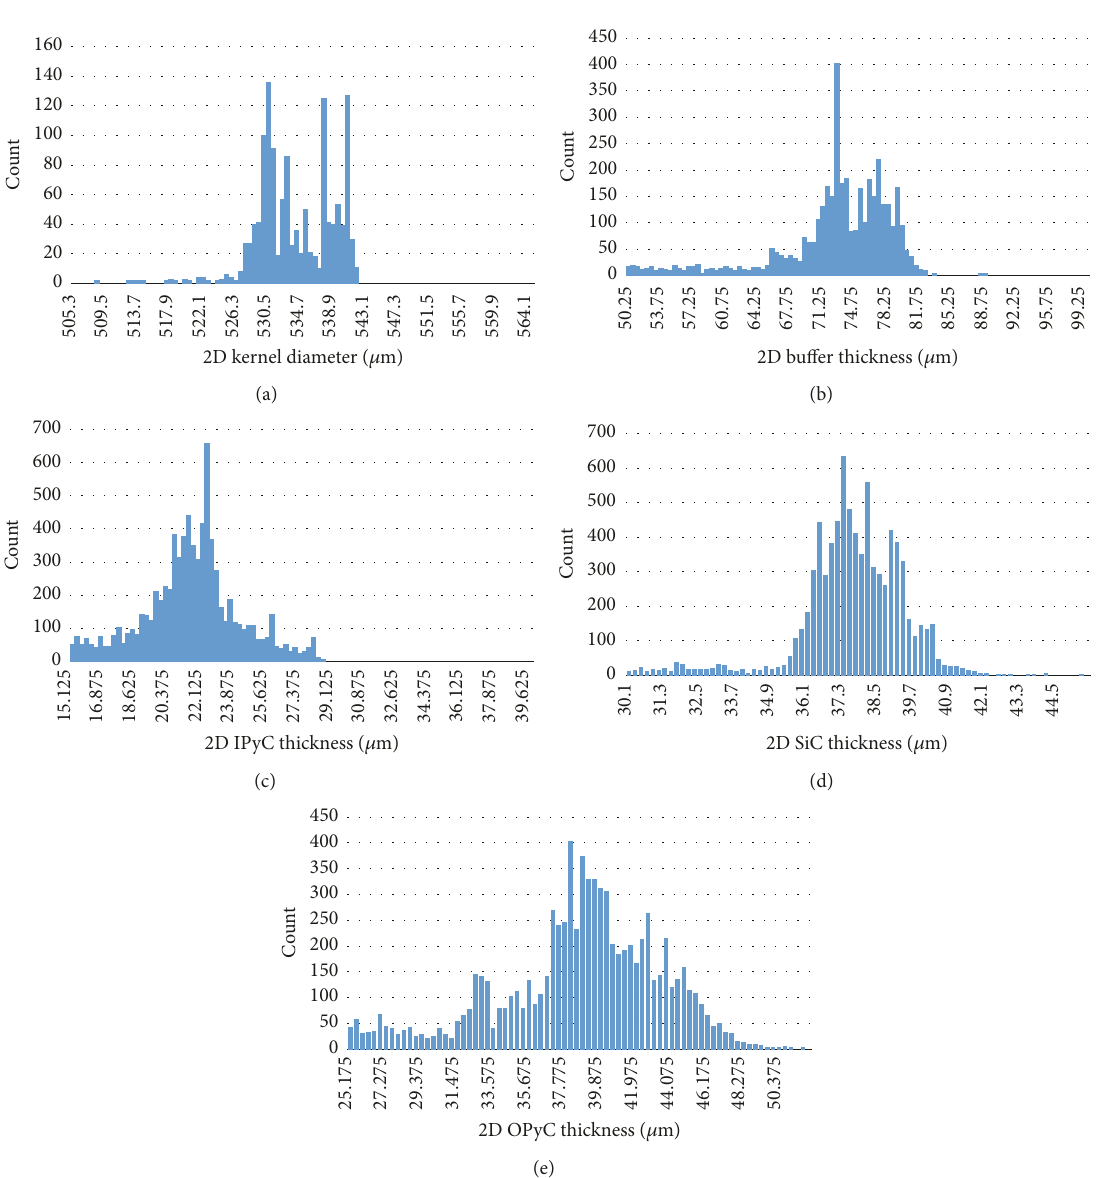
Figure 7: (a) Digital radiograph of the particle and (b) 3D volume rendering of 3 slices of the TRISO particle.